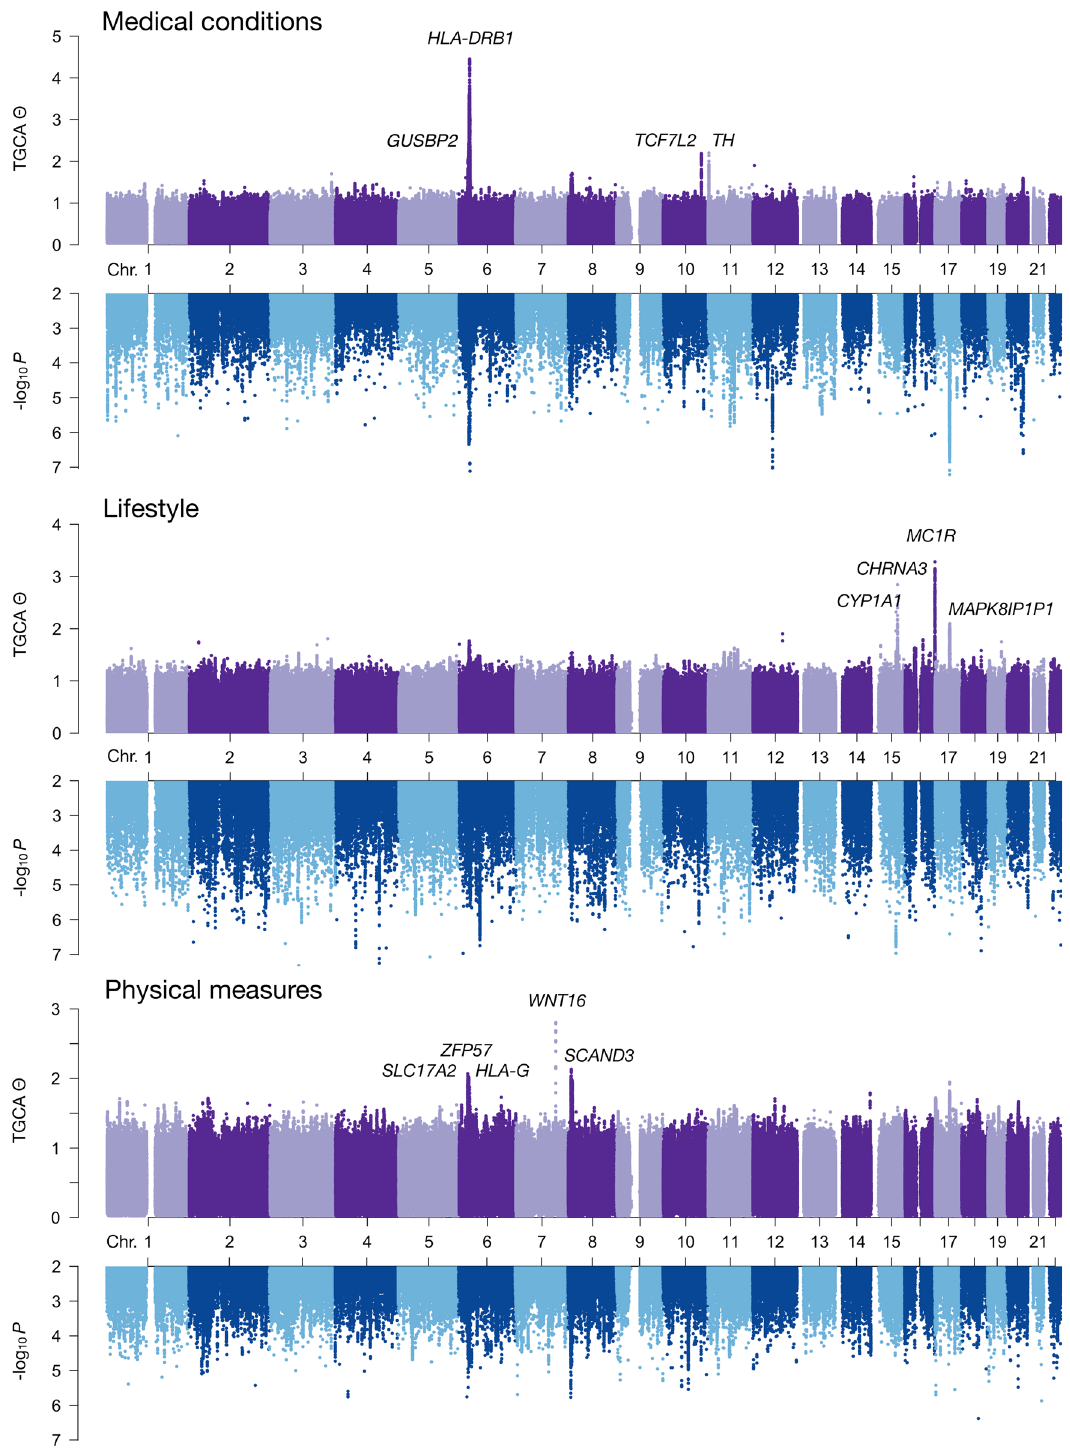
Fig. 2 Genome-wide total genetic contribution assessment (TGCA) ^ Θ and the p -values testing against Θ = 0 in three UK Biobank trait domains. Nearest gene(s) to the lead variant at each top locus are labeled. Source data are provided as genome-wide summary statistics in Data